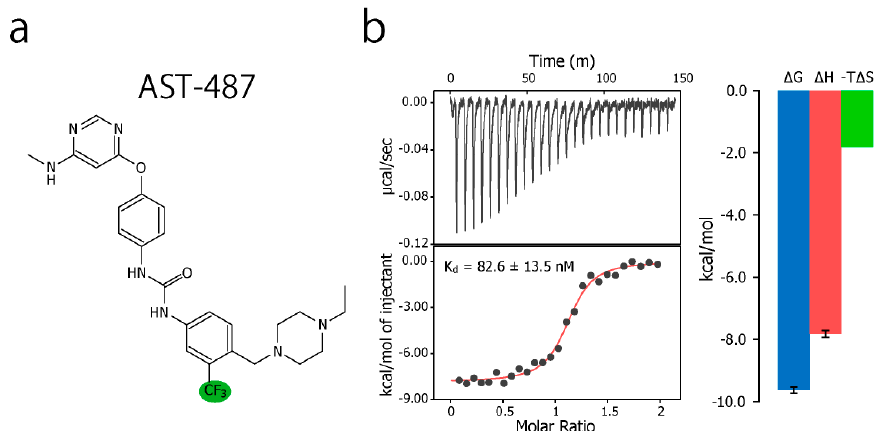
Figure 1. Chemical structure of AST-487 and its binding thermodynamics against p38 α . ( a ) The chemical structure of AST-487, with the CF 3 moiety highlighted in green; ( b ) The isothermal titration calorimetry (ITC) profile and thermodynamic properties of the interaction between AST-487 and p38 α . In the ITC experiment, 50 μ M AST-487 was titrated to 5 μ M p38 α at 25 °C.